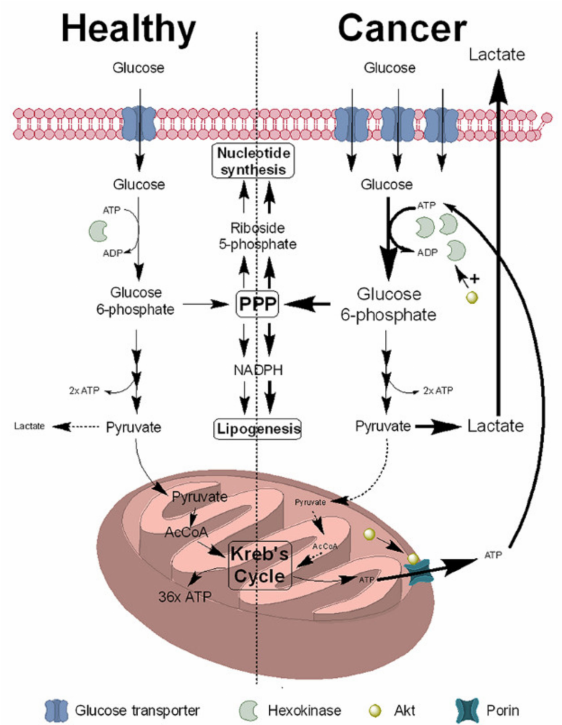
Figure 1. Summary of the metabolic changes within tumour cells arising from the Warburg effect. In healthy cells, glucose is taken up and converted into ATP via oxidative phosphorylation. In the tumour cell, mitochondrial oxidation of pyruvate via the Krebs cycle and the mitochondrial respira- tory chain is reduced, mediated by increased expression of lactate dehydrogenase A and pyruvate kinase M2 which shuttles pyruvate into lactate production. The loss in ATP synthesis is compensated by increased expression of the glucose transporter and hexokinase expression, which is induced by Akt signalling. The increase in hexokinase activity is supported by the diversion of mitochondrial ATP to hexokinase, mediated by the binding of Akt to mitochondrial porin. Intermediate products of glycolysis are diverted into the pentose phosphate pathway (PPP), which generates the riboside 5-phosphate and NADPH arising from the increased demand for nucleotide synthesis and lipogenesis arising from the increasing tumour mass. Excess lactate is excreted from the cell, acidifying the extracellular environment, and thus promoting the tumour phenotype over non-tumour cells. The Warburg effect is not the only change within the neoplastic cell to occur.